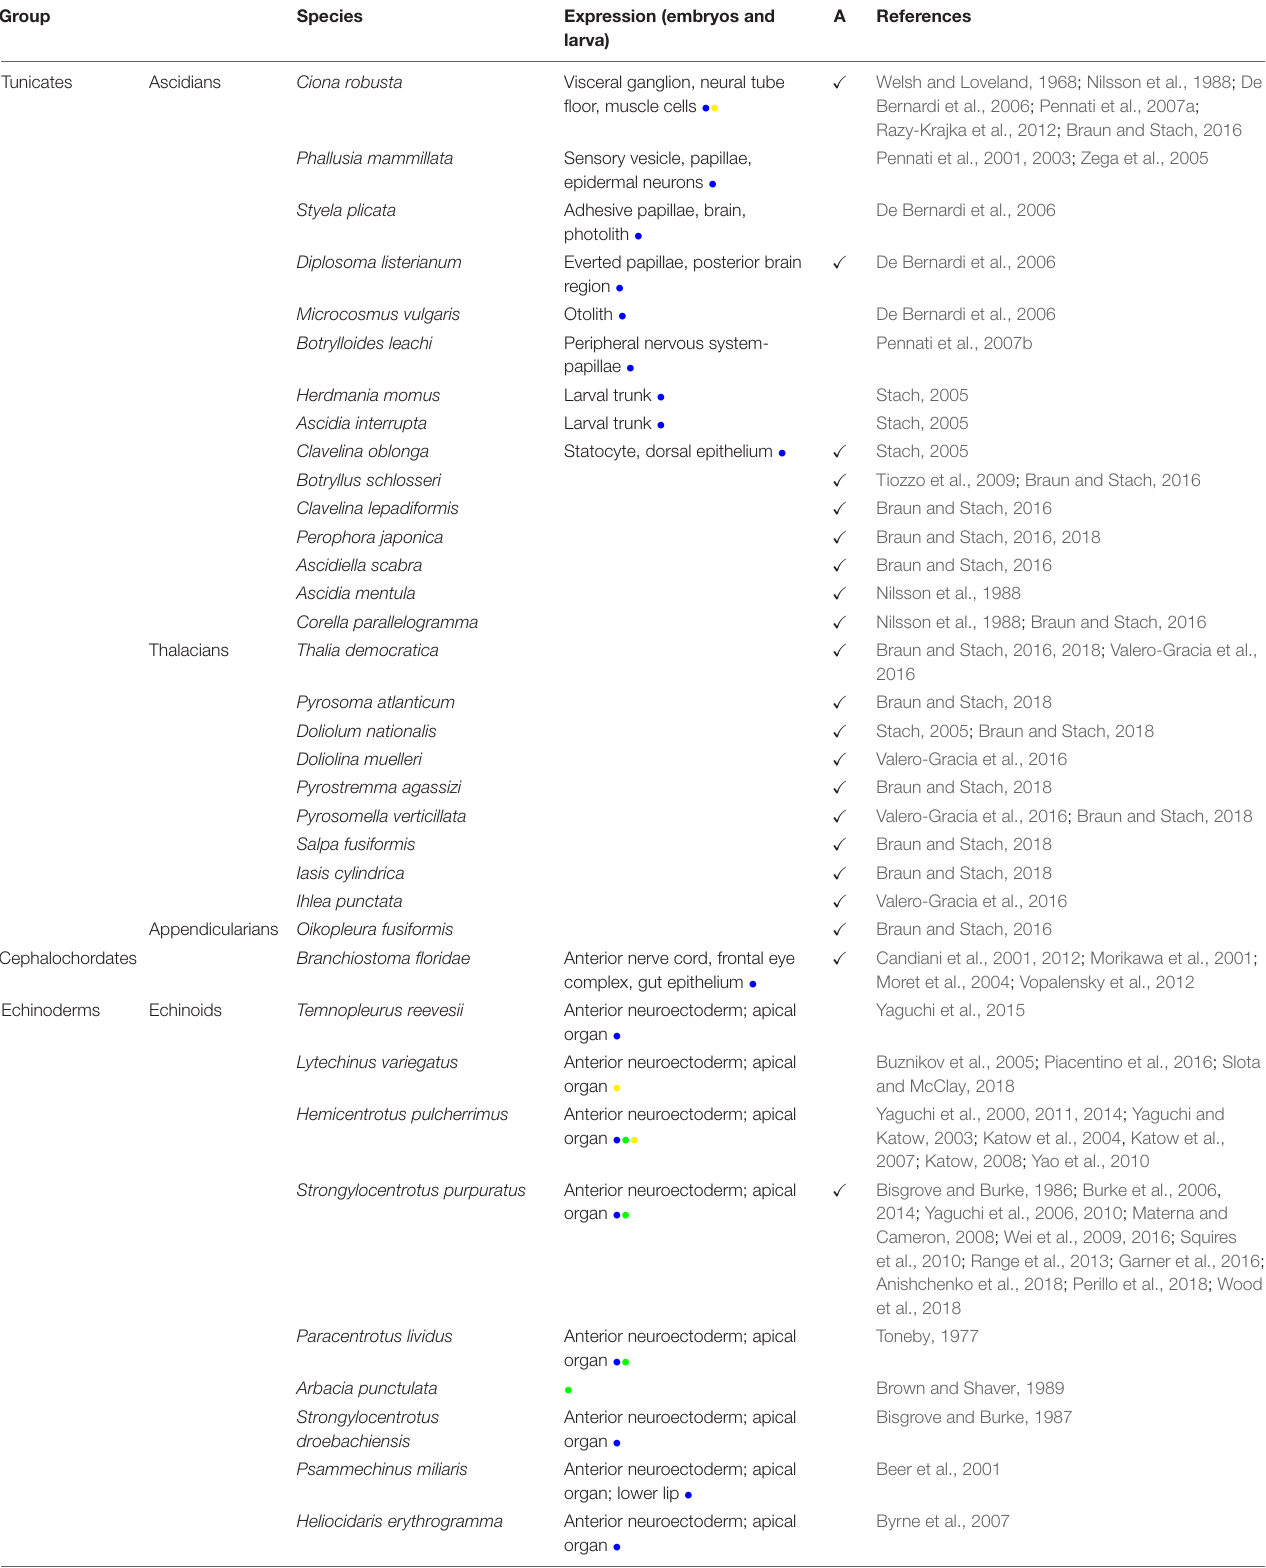
TABLE 2A | (A) Indolamines (Serotonin) distribution in embryos or adult tunicates, cephalochordates, and echinoderms.